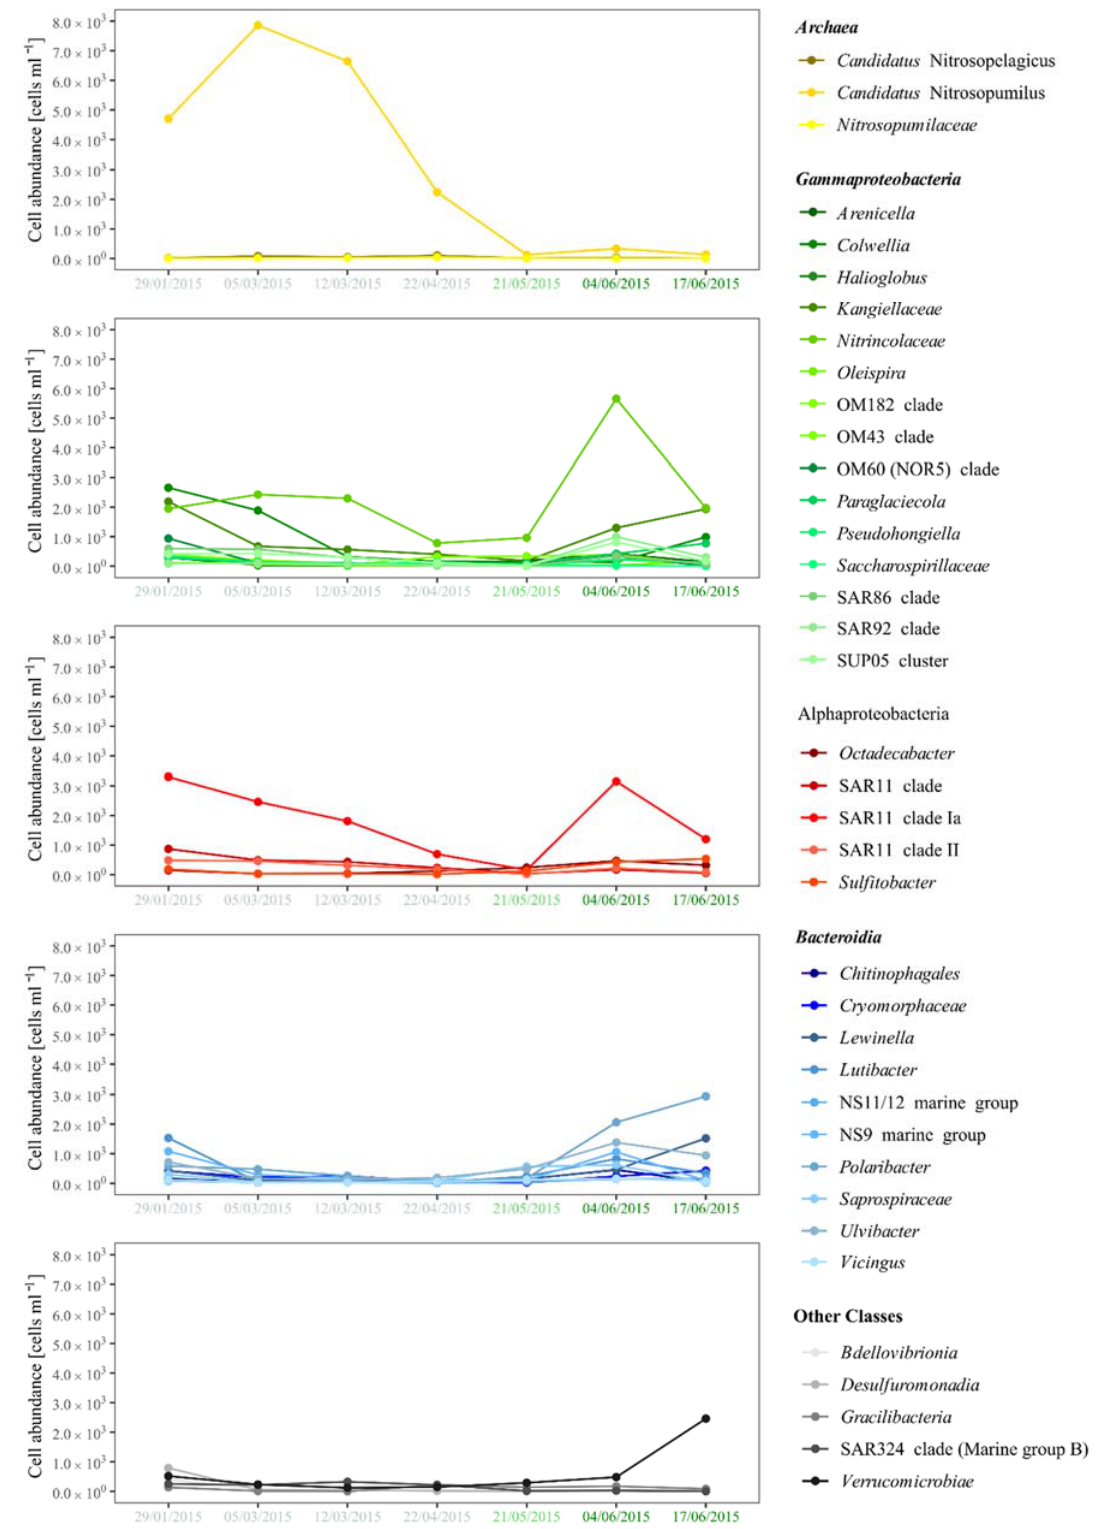
Figure 4. Line plots of bacterial and archaeal abundance of the most abundant taxa based on the rel. abundance and the flow cytometry derived cell numbers. The color of the dates indicates the season (light green = winter, green = spring, and dark green = summer) and the ice algae bloom (dark